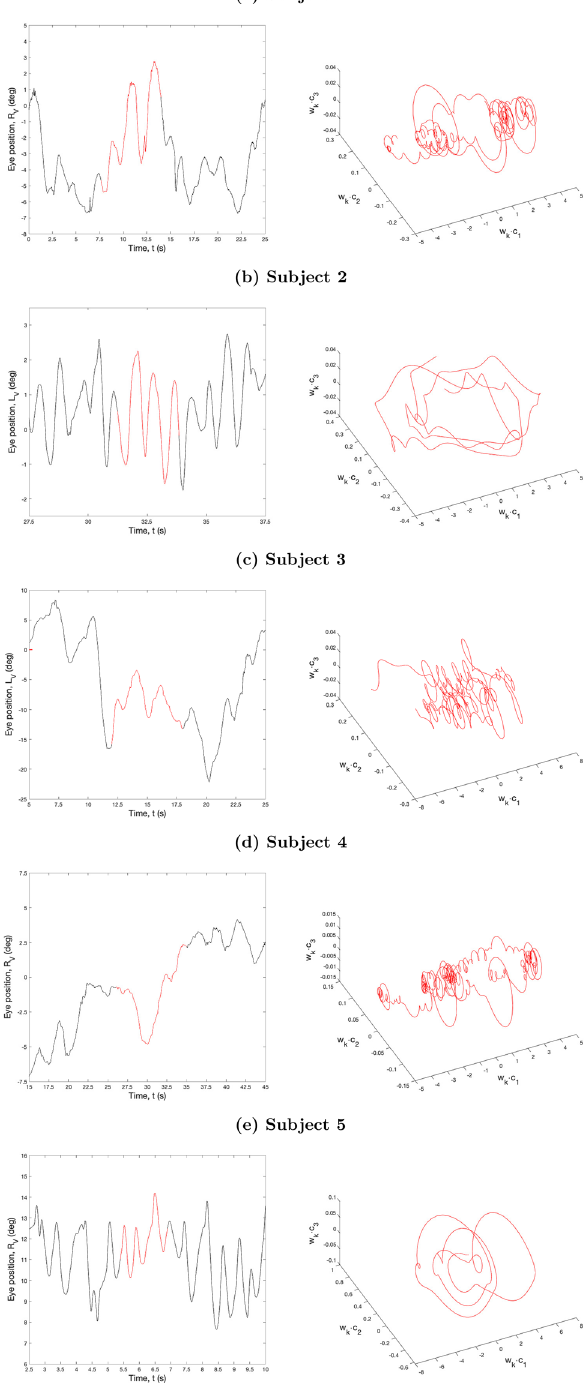
Figure 6. Phase space reconstructions. Left column: Time series segments for each subject showing the unstable periodic orbits (UPO) extracted in each case (red lines). Right column: The attractors reconstructed from the UPOs using delay embedding (see text for further